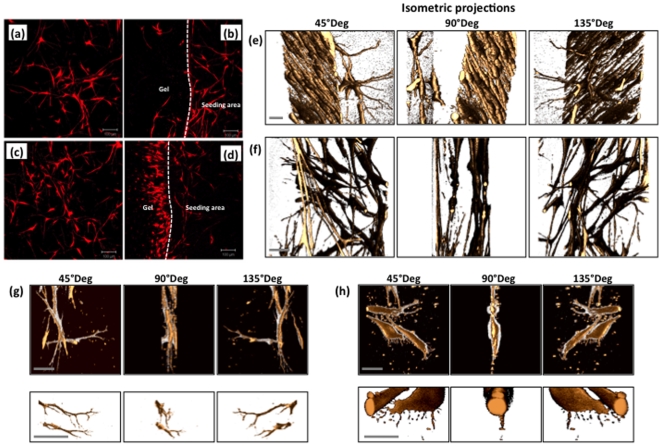
HDF cells seeded in a pre-cast fibrin clot gel stained using Rhodamine B octadecyl ester-loaded polymersomes and subsequently monitored using fluorescent microscopy.(a) Imaged after 7 days at the initial cell seeding area. (b) Imaged after 7 days at the interface between the initial cell seeding area and the pre-cast gel. (c) Imaged after 14 days at the initial cell seeding area. (d) Imaged after 14 days at the interface between the initial cell seeding area and the pre-cast gel. Figure bar = 0.1 mm. 3D volumetric reconstruction of HDF cells migrating within fibrin-clot gels imaged at the migration front areas (e) and at the initial cell seeding area (f). Details of single cells and their filipodia imaged at the seeding area (g) and the migration front (h). Figure bar = 0.01 mm.